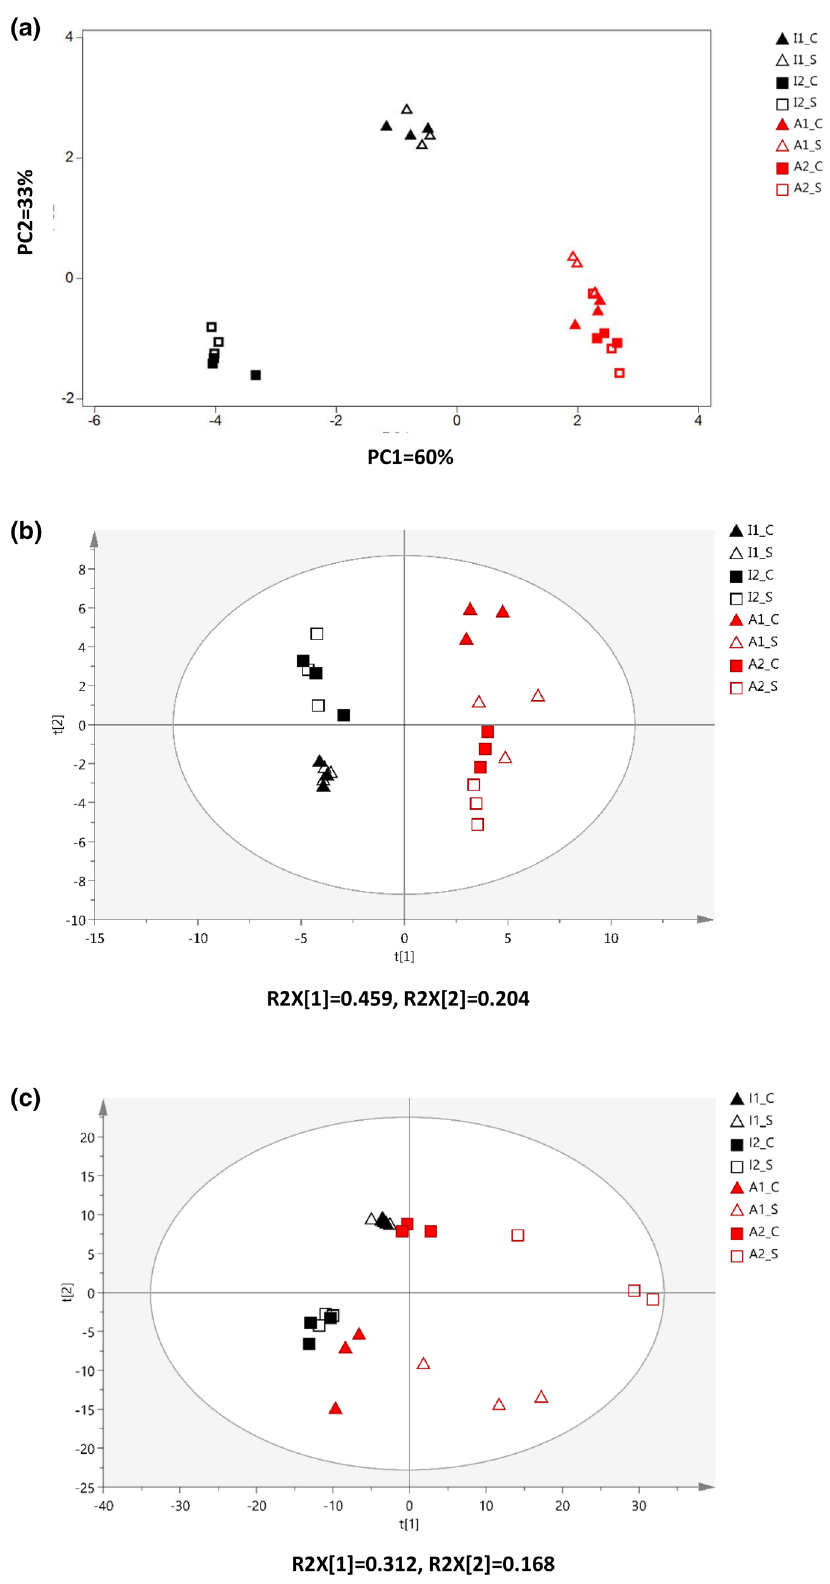
Figure 1. Principal component analysis (PCA) of industrial and artisanal cheeses for ( a ) microbiota, ( b ) GC-MS metabolites and ( c ) LC-MS metabolites. I: industrial, A: artisanal; C: core, S: Surface; number indicates different brand for each artisanal and industrial